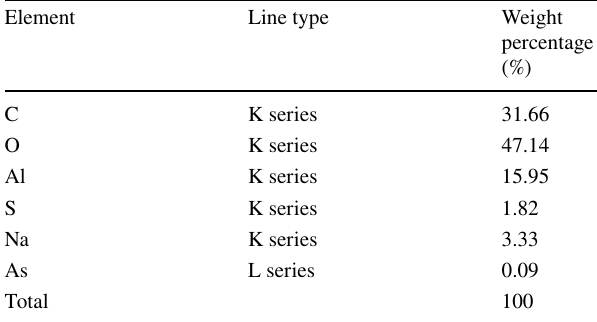
Table 5 EDS results of sludge sample